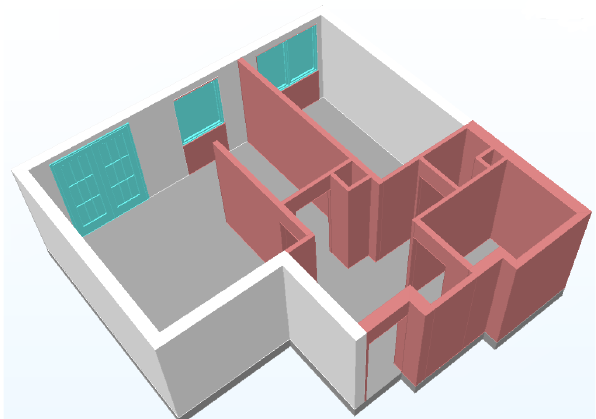
Fig ure. 4. Example of low detailed BIM object - newly built